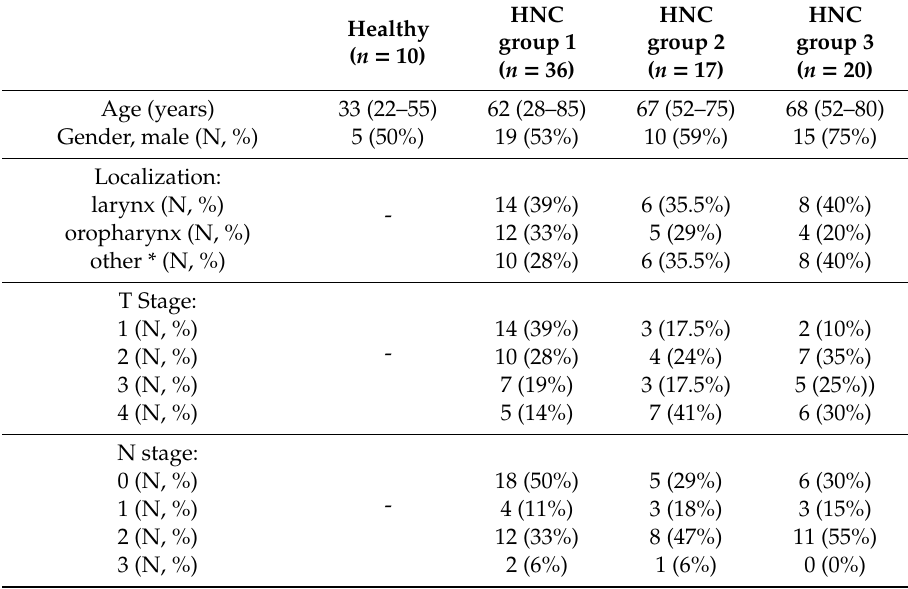
Table 1. Clinico-pathological characteristics of patients enrolled in this study. HNC—head and neck